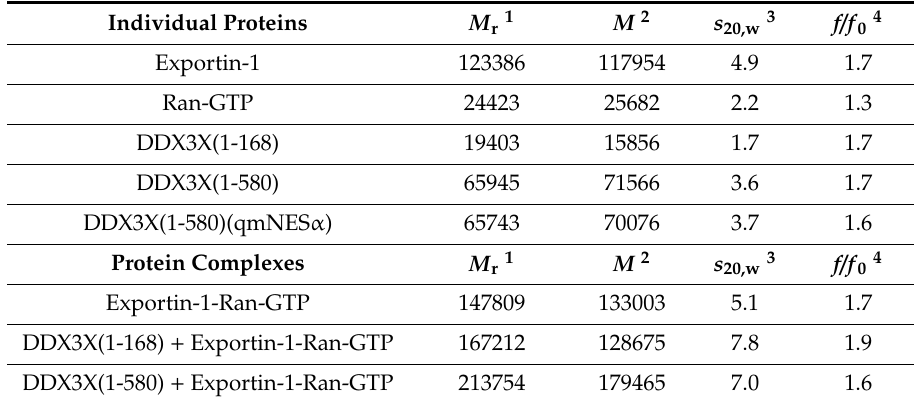
Table 1. Hydrodynamic properties of recombinant DDX3X(1–580) or mutants thereof, exportin-1, Ran-GTP, and their resulting complexes. Related to Figure 3. Individual